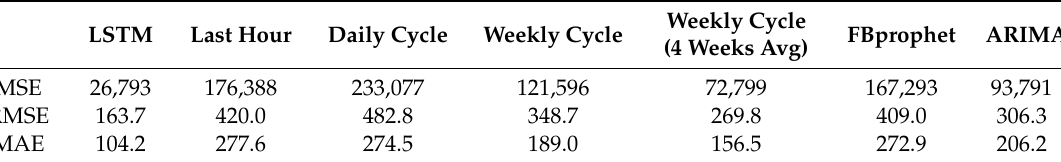
Table 1. Overall comparison results of the LSTM model and the baseline approaches in terms of MSE,